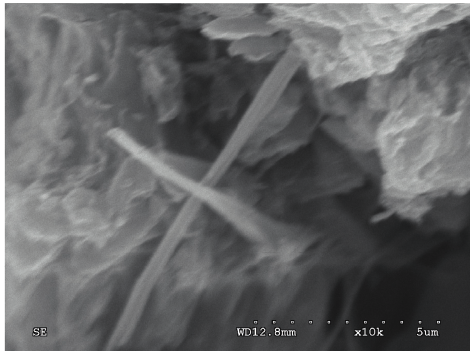
Figure 13: The soil of curing 7d and being magnified 10000